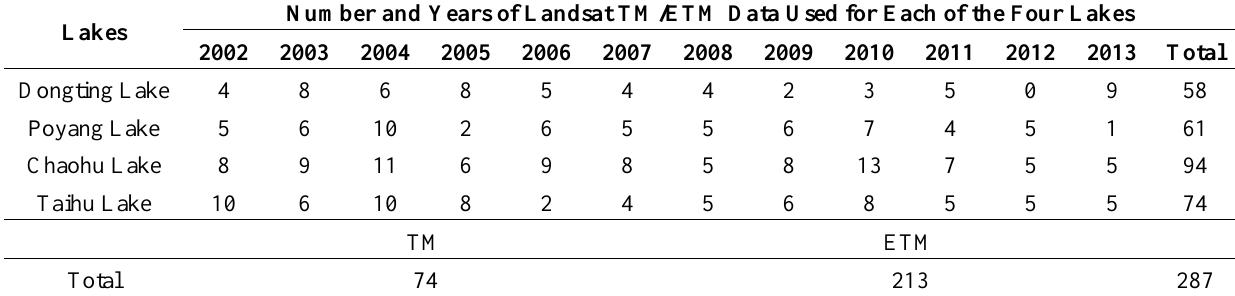
Table 1. Data selection in the study